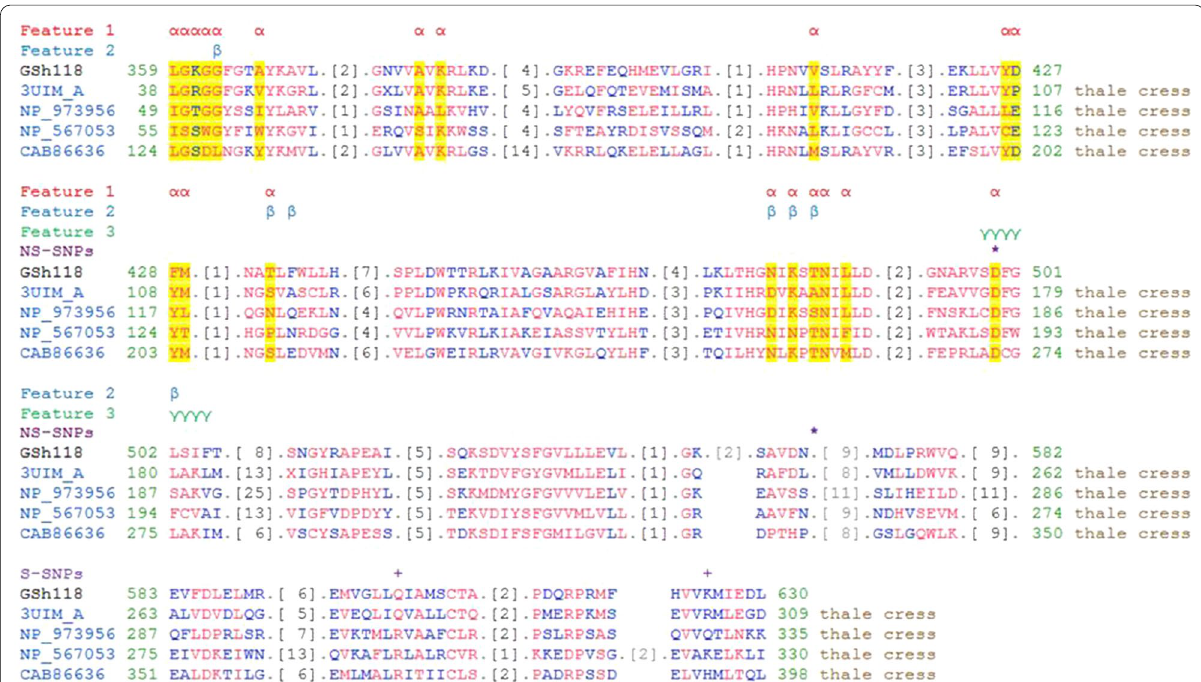
Fig. 8 Multiple amino acid sequence alignment of STKs and IRAKs domains in the putative protein encoded by GSH118 gene in the sequencing region of MCC133 and ILC263 lines compared to the domains (3UIM_A, NP_973956, NP_567053 abd CAB86636) reported in Arabidopsis thaliana (thale cress). α: Feature 1 (ATP binding conserved residues), β: Feature 2 (Polypeptide substrate binding site conserved residues), γ: Feature 3 (Activation loop conserved residues), *: Non-synonym SNP (NS-SNP) and : Synonym SNP +